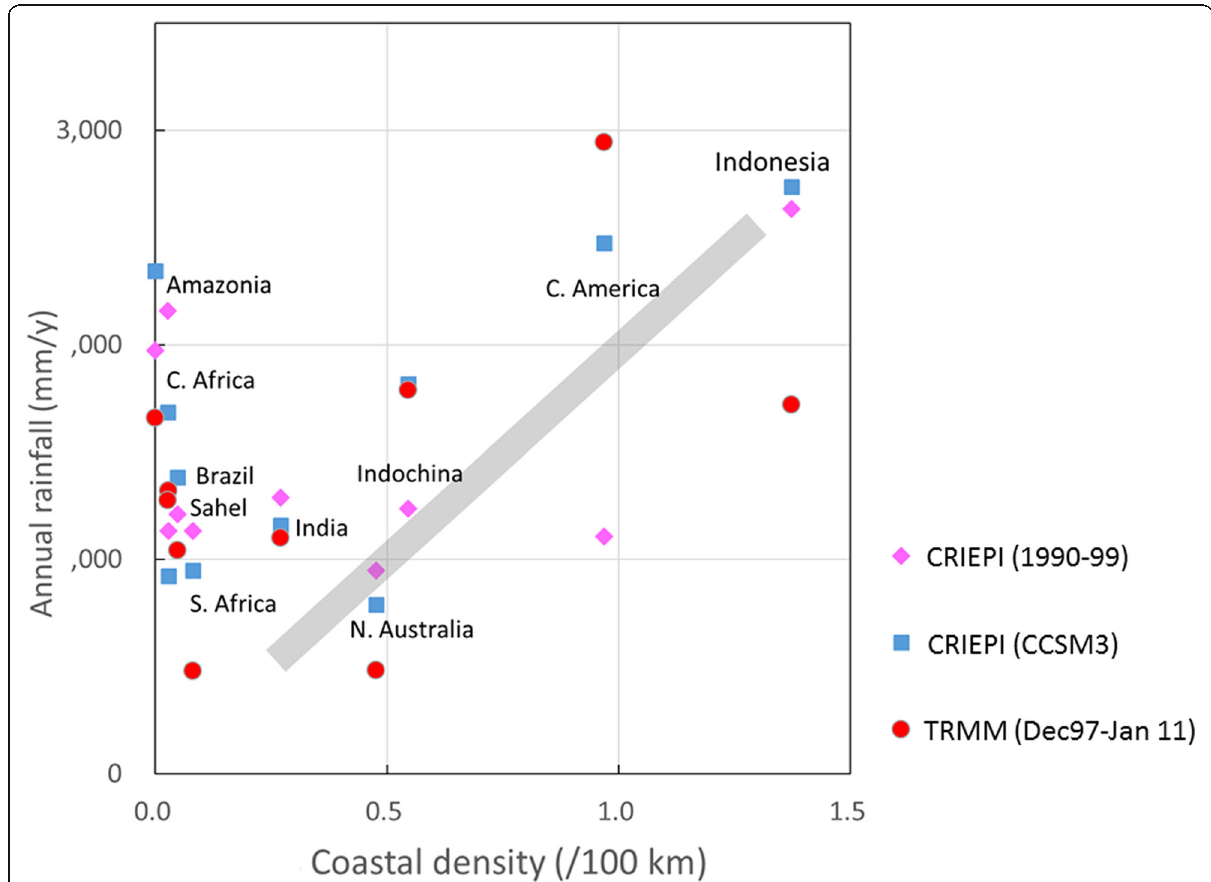
Fig. 14 Regional rainfall listed in Table 1, as a function of “ coastal density ” (modified from Yamanaka